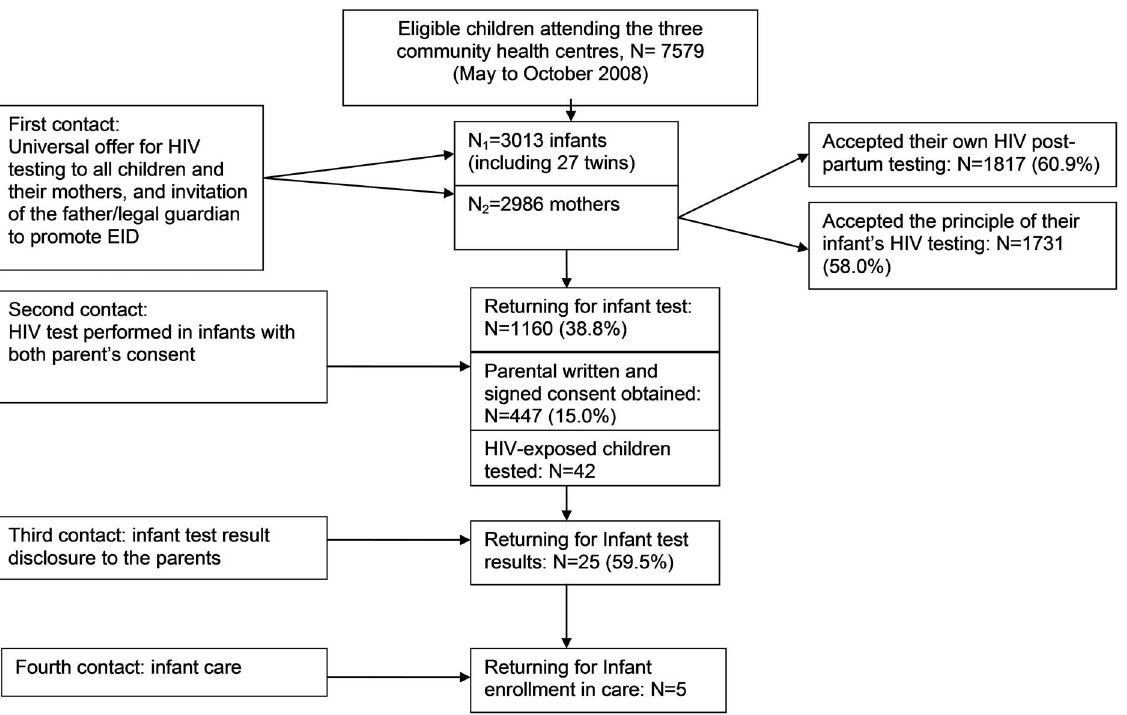
Figure 1. Flow diagram of the population selection after a universal offer for early infant HIV diagnosis (N=3013).